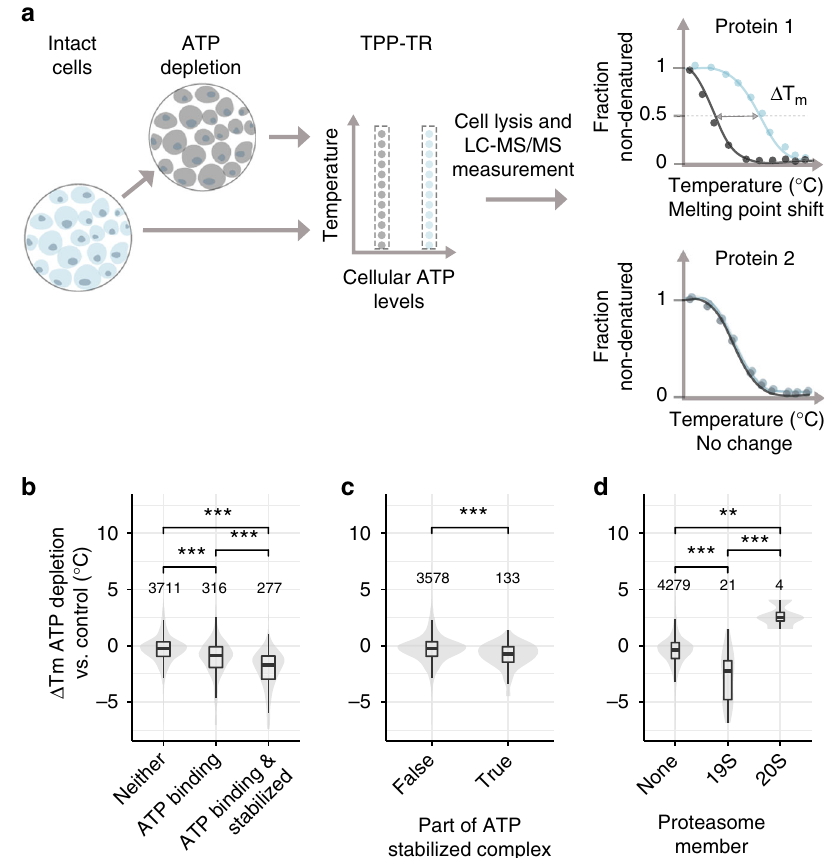
Fig. 2 Effect of ATP depletion of proteome thermal stability. a Experimental setup of TPP on untreated cell (indicated in blue) and cells depleted of ATP by inhibiting glycolysis and oxidative phosphorylation with a combination of 10 mM 2-deoxyglucose and 1 nM Antimycin-A (indicated in grey). Dotted rectangular box corresponds to one TMT10 experiment. b Changes in median melting points of non-ATP-binding proteins, ATP-binding proteins, and ATP- binding proteins that were stabilized by ATP in the crude lysate experiment upon ATP depletion in cells from three independent experiments. Signi fi cance levels obtained from a Wilcoxon signed-rank test were encoded as * p < 0.05, ** p < 0.01, and *** p < 0.001. c Changes in melting points of protein complex subunits stabilized by ATP in the crude lysate experiment (right), and all other proteins (left) upon ATP depletion in cells. Signi fi cance levels obtained from a Wilcoxon signed-rank test were encoded as * p < 0.05, ** p < 0.01, and *** p < 0.001. d Changes in melting points of 19S and 20S proteasome subunits,